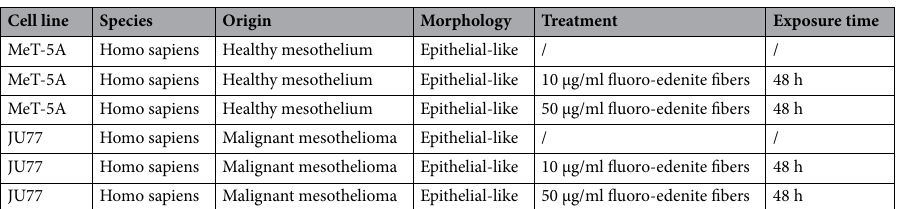
Table 1. Characteristics of cell lines and functional in vitro